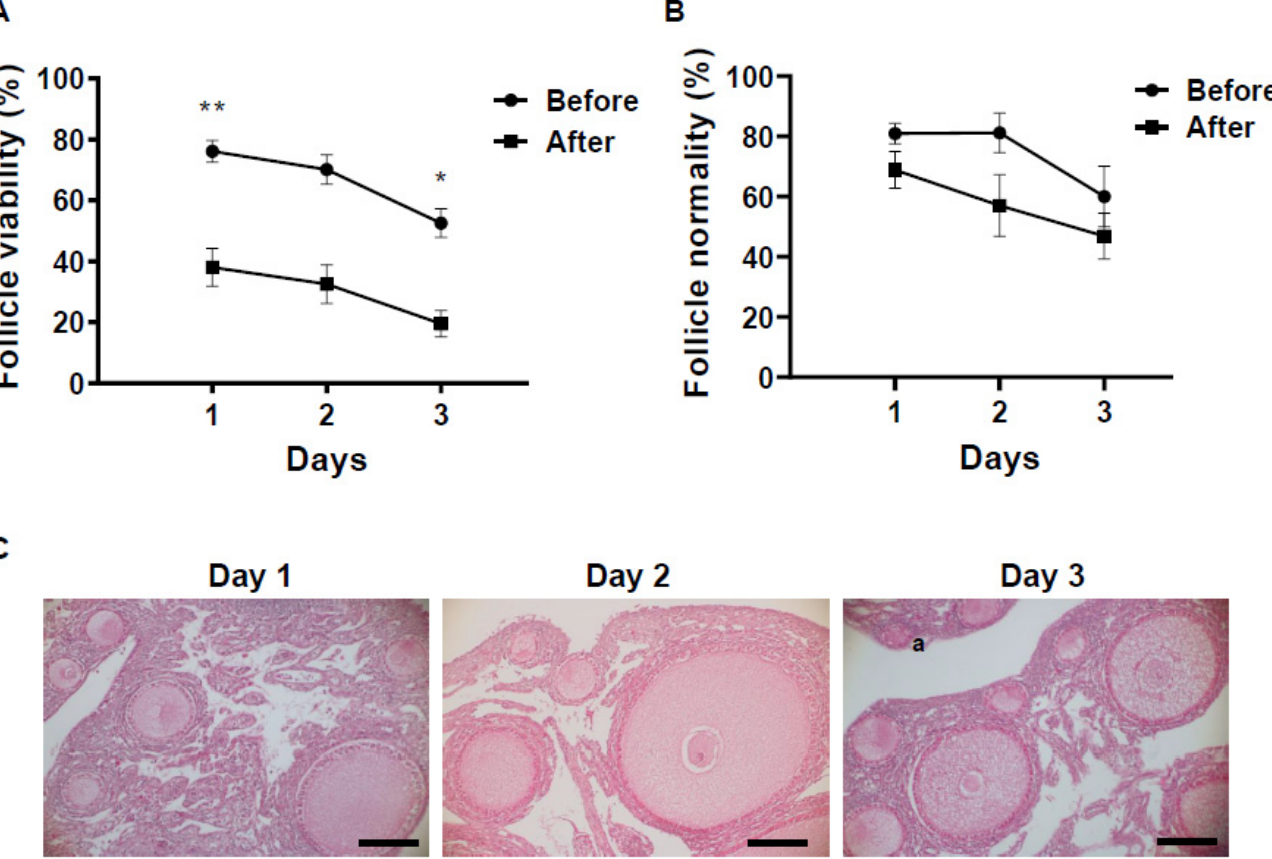
Figure 5. Influence of storage periods on follicle viability after vitrification of ovarian tissues ( A ) Mean ( ± SEM) percentages of follicle viability after vitrification of ovarian tissues stored for different periods (for 1 to 3 days). * indicate statistically significant differences (* p < 0.005, ** p < 0.001) in the percentages of survived follicles. ( B ) Mean ( ± SEM) percentages of morphologically normal follicle in ovarian tissues vitrified after ovary storage for different periods (for 1 to 3 days). ( C ) Histomicrographs of ovarian tissues vitrified after ovary storage for different periods stored at low temperature for 1 to 3 days). “a” indicates the abnormal follicles. Bar = 100 µ